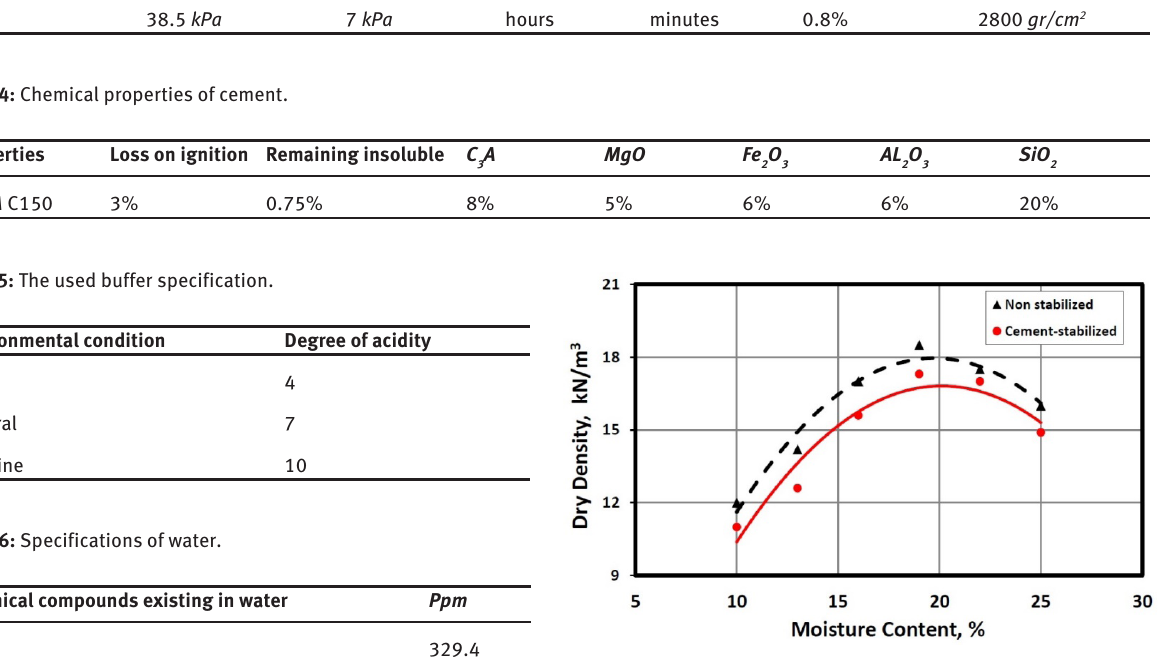
Figure 7: Density curve of cement-stabilized and unsterilized